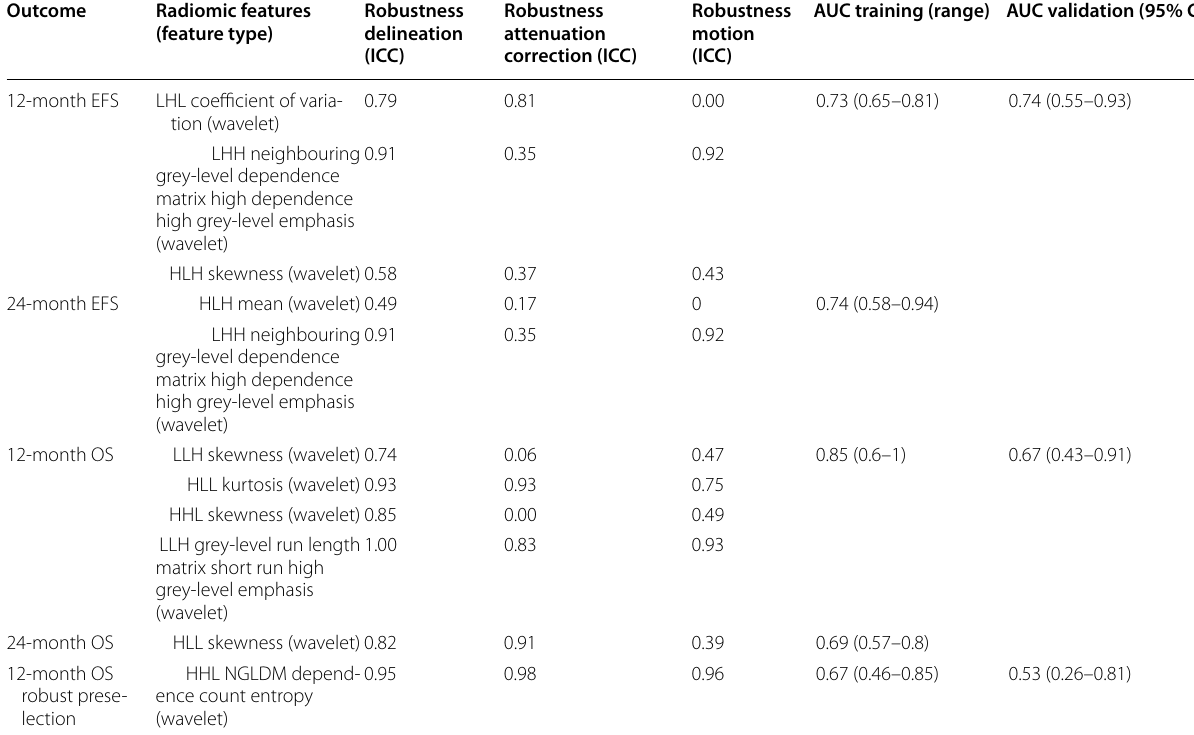
Results multivariable analysis for EFS and OS. Radiomic features were selected using backward selection. Good classification performances of models without robust preselection were observed for the training cohort (AUC 0.67) and weak in validation (AUC = =